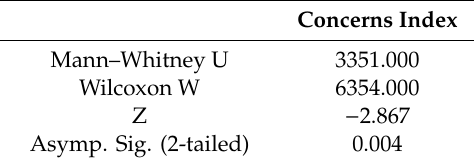
Table 10. Mann–Whitney U test statistics concerns index and gender.